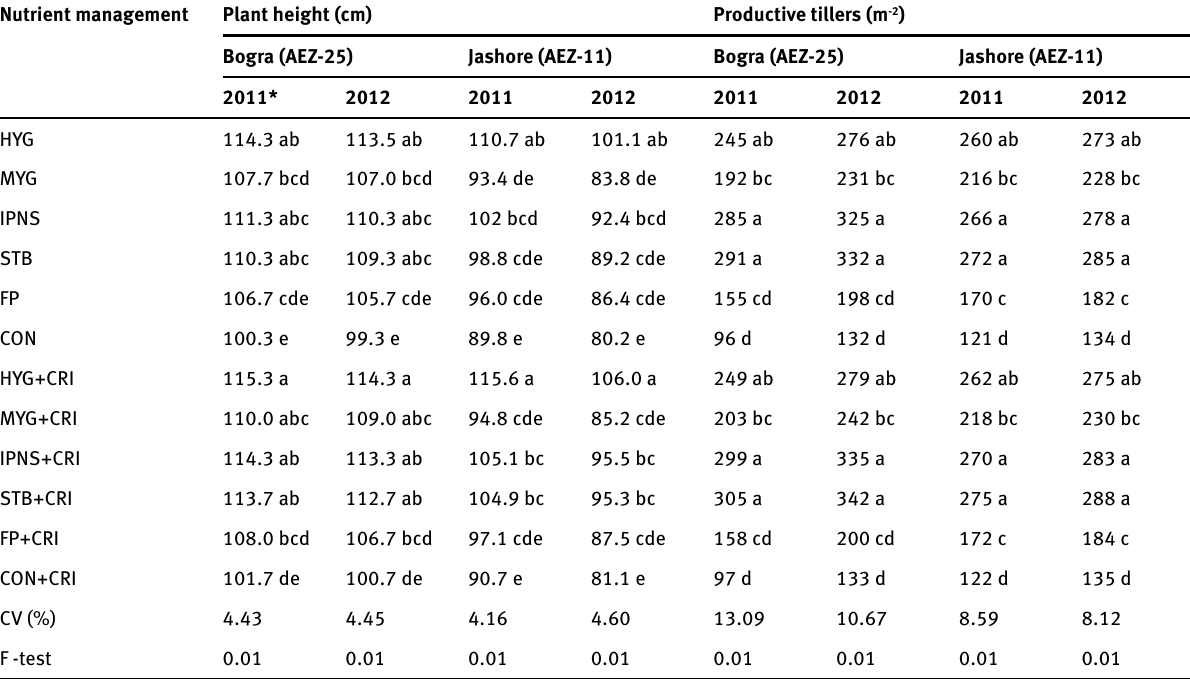
Table 3: Influence of different nutrient management strategies on plant height and productive tillers of rainfed monsoon rice in two locations of Bangladesh Nutrient